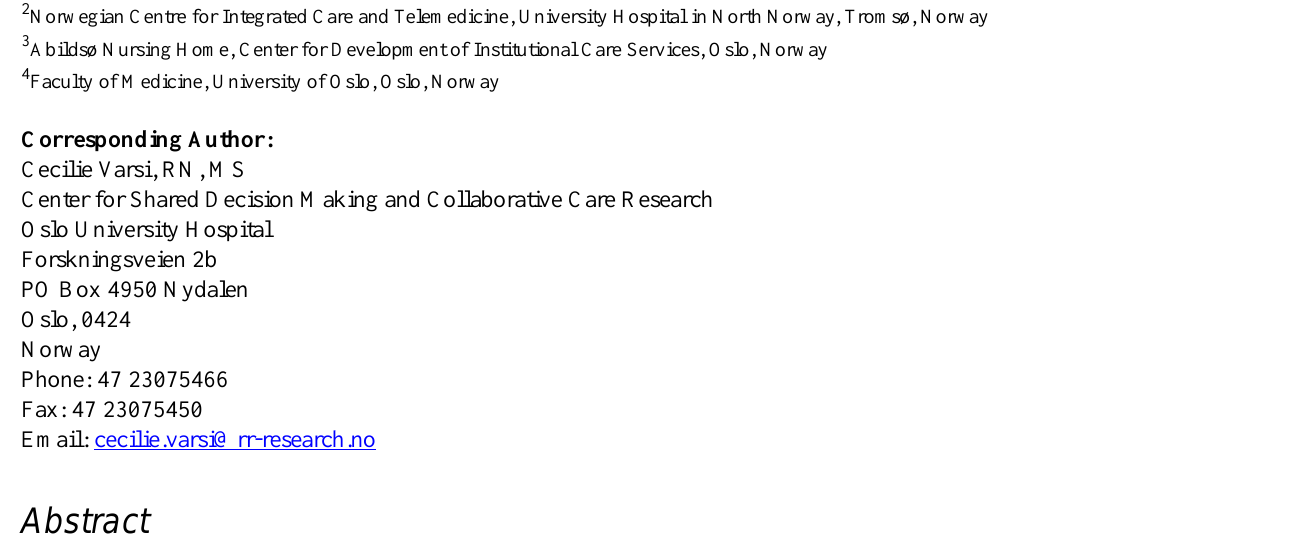
communication; email; Internet; interviews as topic; patient dropouts; patient non-use; patient preference; professional-patient relations; qualitative